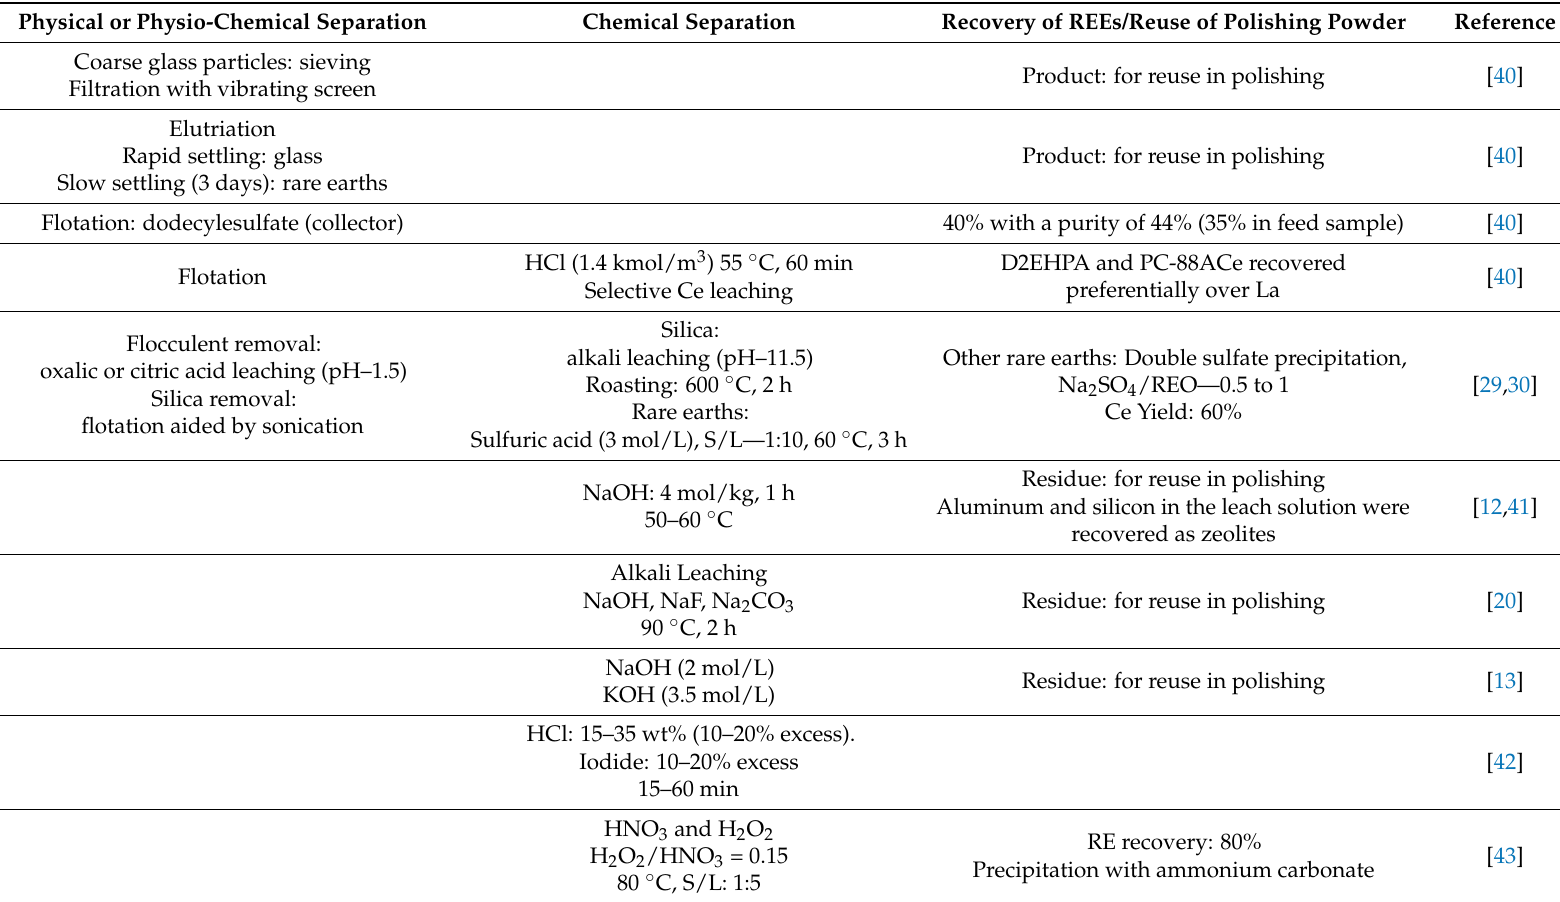
Table 4. Different studies on recovery and recycling of rare earths from glass polishing waste by using physical, chemical and/or physico-chemical